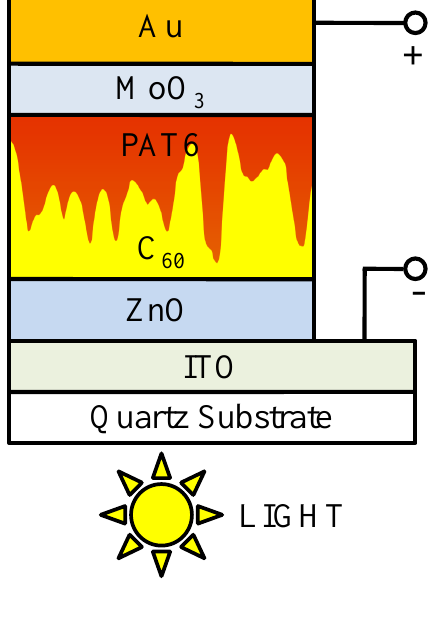
Figure 1. Schematic structure of interpenetrating heterojunction organic thin-film solar cell with metal oxide buffer layers.